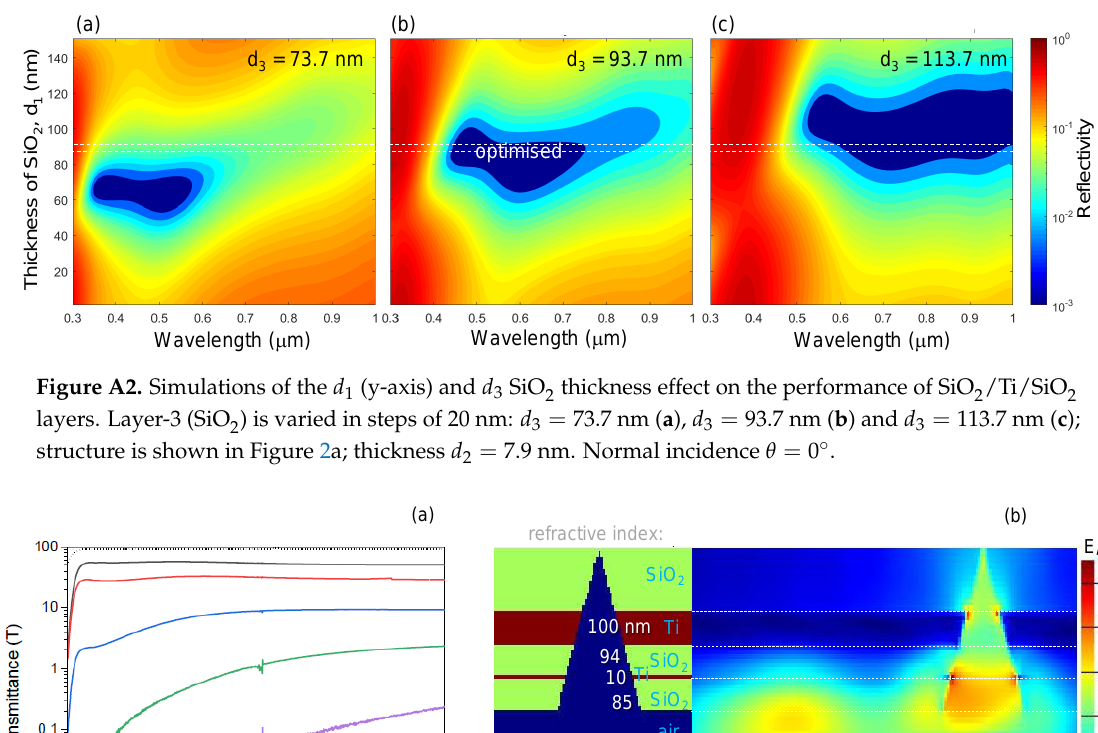
Figure A3. ( a ) Titanium mirror layer ( d m ) thickness effect on the transmittance of incident light. Total integral transmittance T [%] is calculated from area under the curve; ( b ) finite difference time domain (FDTD, Lumerical) simulation on light localization in the optimized black-metal stack using Ti. The triangular groove is inserted for visualization of possible changes to light intensity in a simulated laser ablated region. In the pristine region of the impedance matched section, light is localized on the front interface (light propagation is shown by arrow). E-field on incident plane wave E 0 = 1